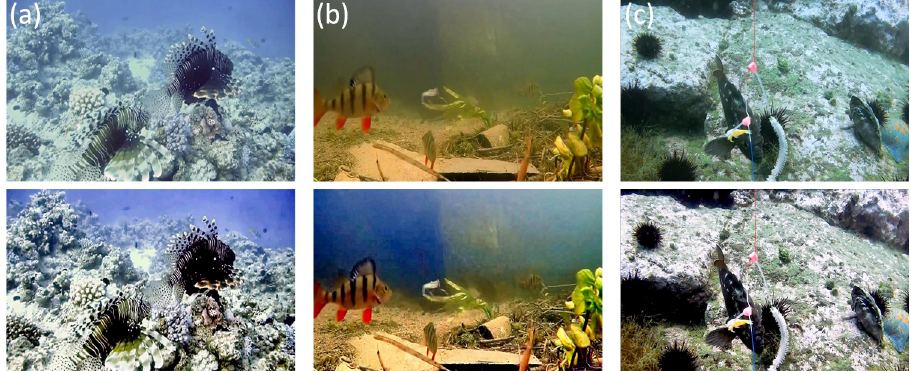
Fig 15. Real underwater video test. (a) Image from video 1; (b) Image from video 2; (c) Image from video